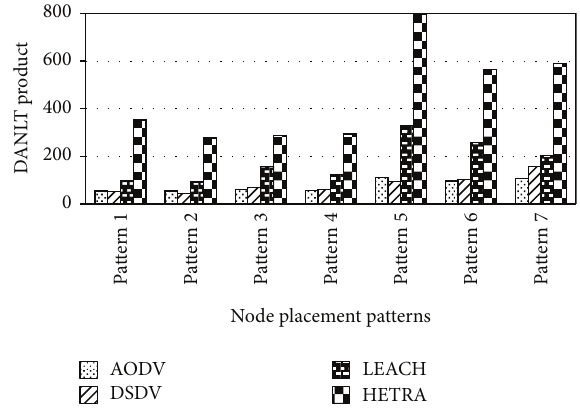
Figure 15: DANLT product for various routing algorithms with TCP/EXP congestion